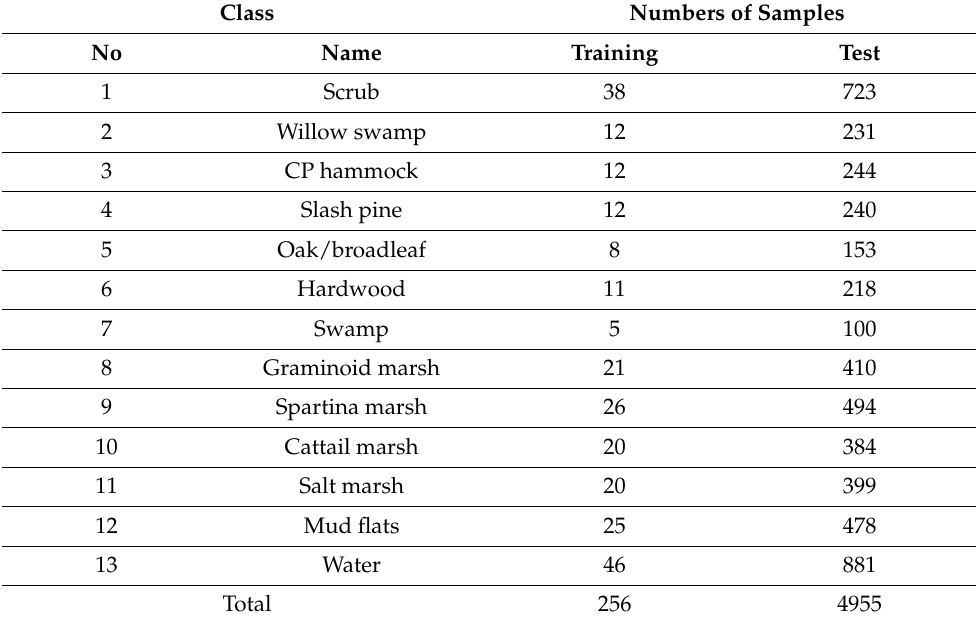
Table 4. Number of training and test samples in the KSC data set.